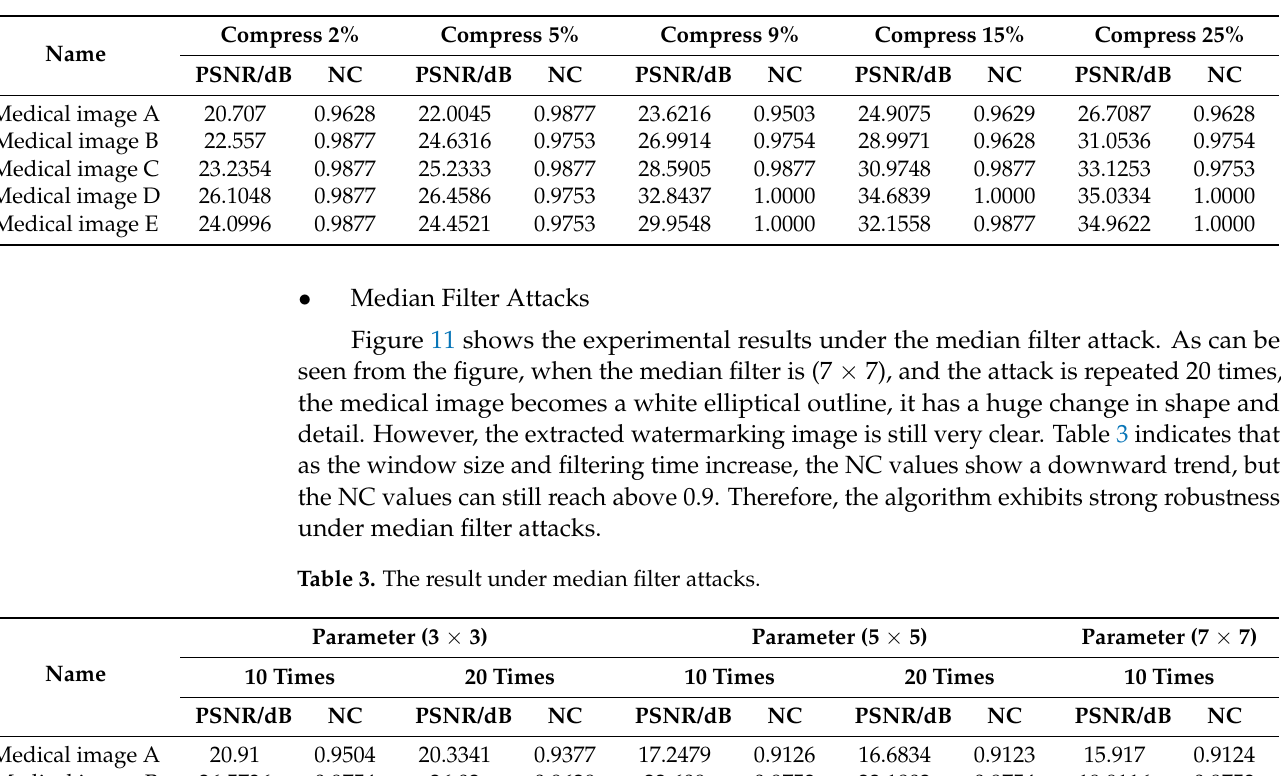
Figure 10. Attacked medical images and restored watermarking images under JPEG compression 2%: ( a , a1 ) brain and extracted watermarking image; ( b , b1 ) chest and extracted watermarking image; ( c , c1 ) fundus blood vessels and extracted watermarking image; ( d , d1 ) hand and extracted watermarking image; and ( e , e1 ) breast and extracted watermarking image.